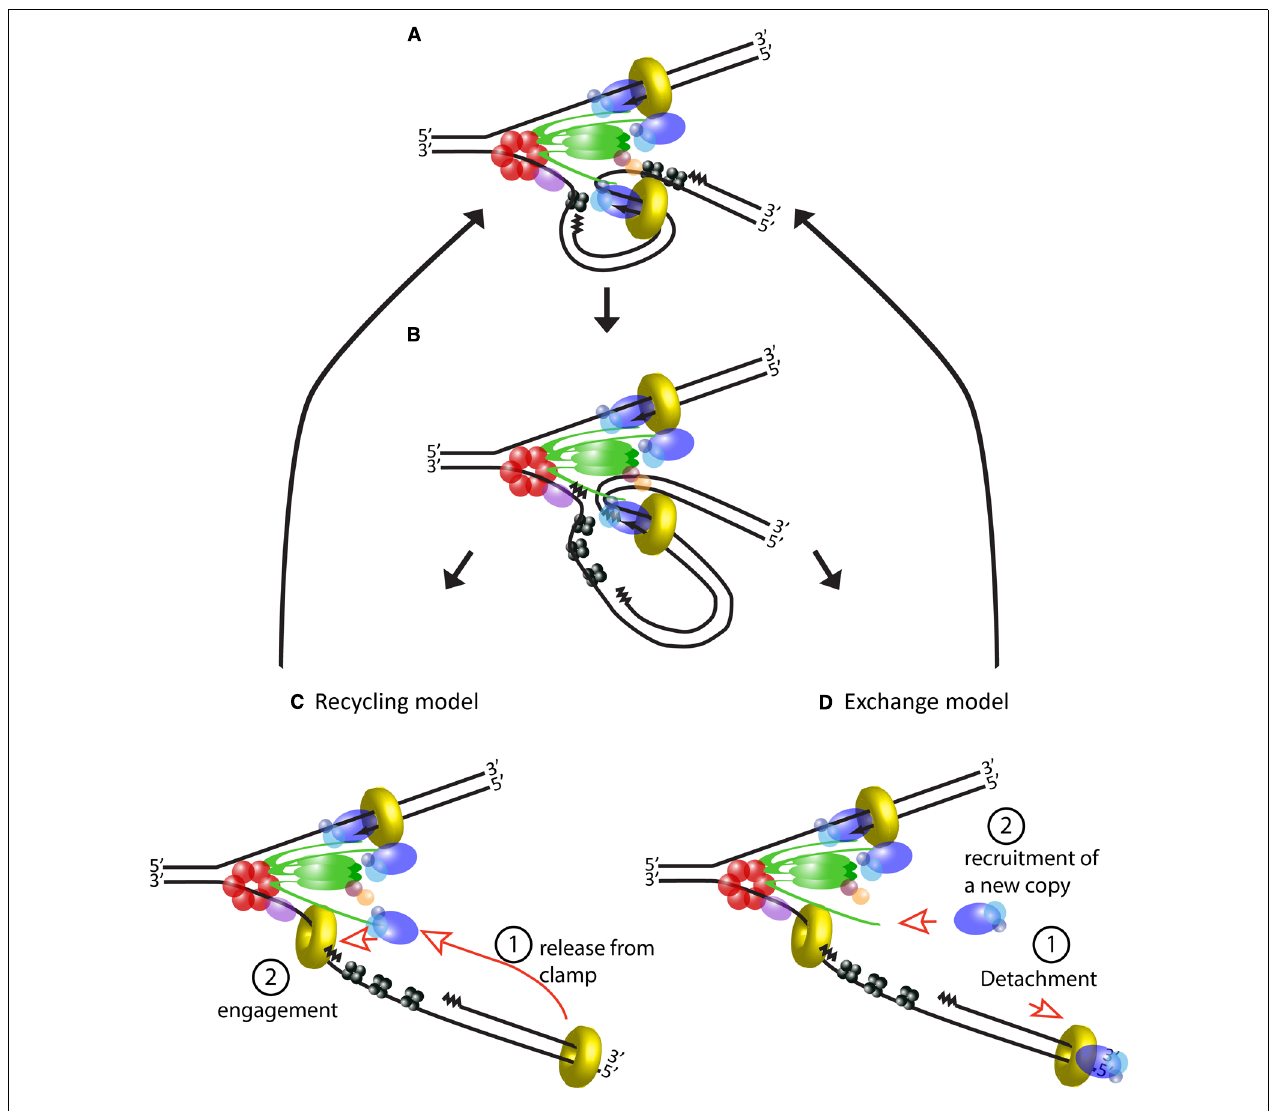
FIGURE 3 | Usage of DNA polymerase during lagging strand synthesis. (A) Schematic of the E. coli replisome during the elongation step of an Okazaki fragment. (B) Lagging strand polymerase meets the RNA primer of the previous Okazaki fragment and stops synthesis. (C) Current model of events following completion of an Okazaki fragment. DNA polymerase is released from the β clamp (step 1) and the same molecule rebinds to a new β clamp to start the next Okazaki fragment (step 2). (D) An